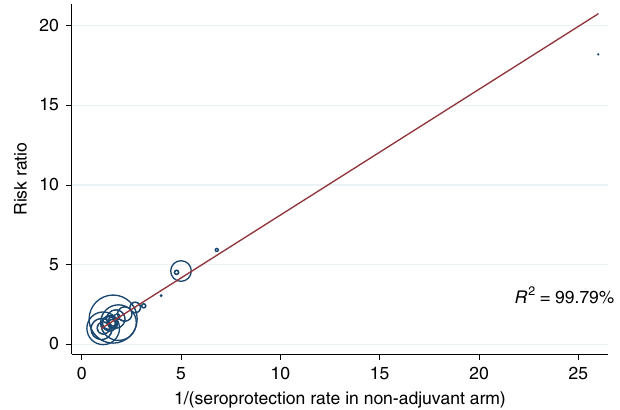
Fig. 4 Meta-regression showing a linear relationship (slope = 0.79, P < 0.001) between the ratios of the seroprotection rate against H1N1 after the fi rst dose and the inverse of seroprotection rate in non-adjuvanted arm, with an R 2 of 99.79%.